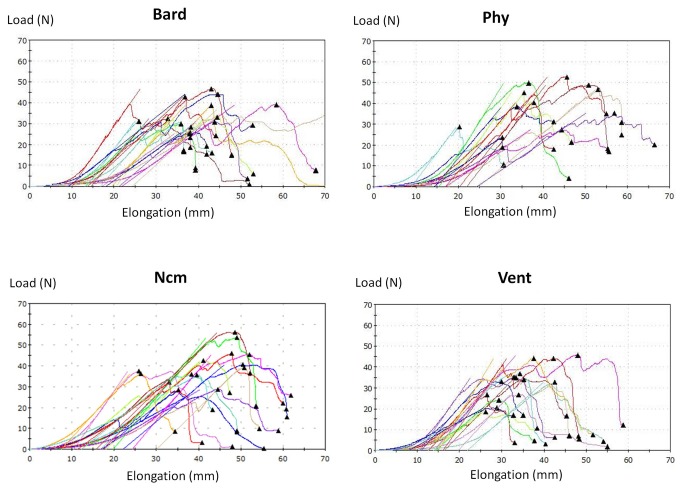
Load (N)/Elongation (mm) curves of the different meshes.The Load/Elongation curves of all the different groups, at 90 days, were represented in the figure. From these curves the Young´s modulus of the different groups of our study were calculated and statistically analyzed. Bard meshTM (Bard), PhysiomeshTM (Phy), new composite mesh (NCM), VentralightTM (VL).